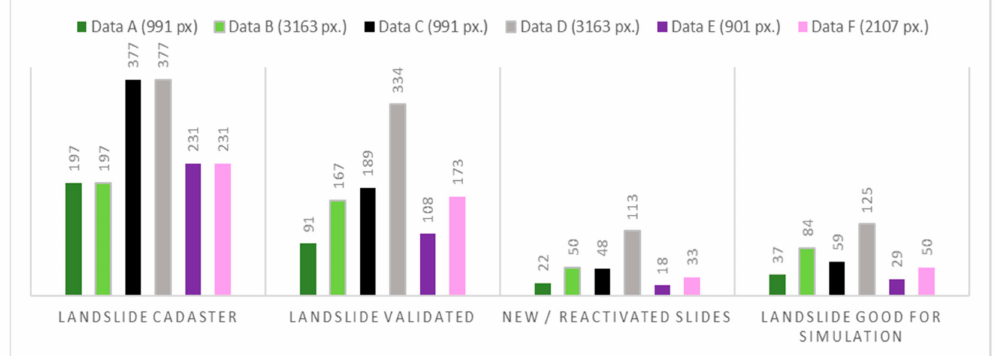
Figure 14. Number of validated landslides against number of existing inventory landslides. The area extension of the six datasets, represented by different colors, is shown in Figure